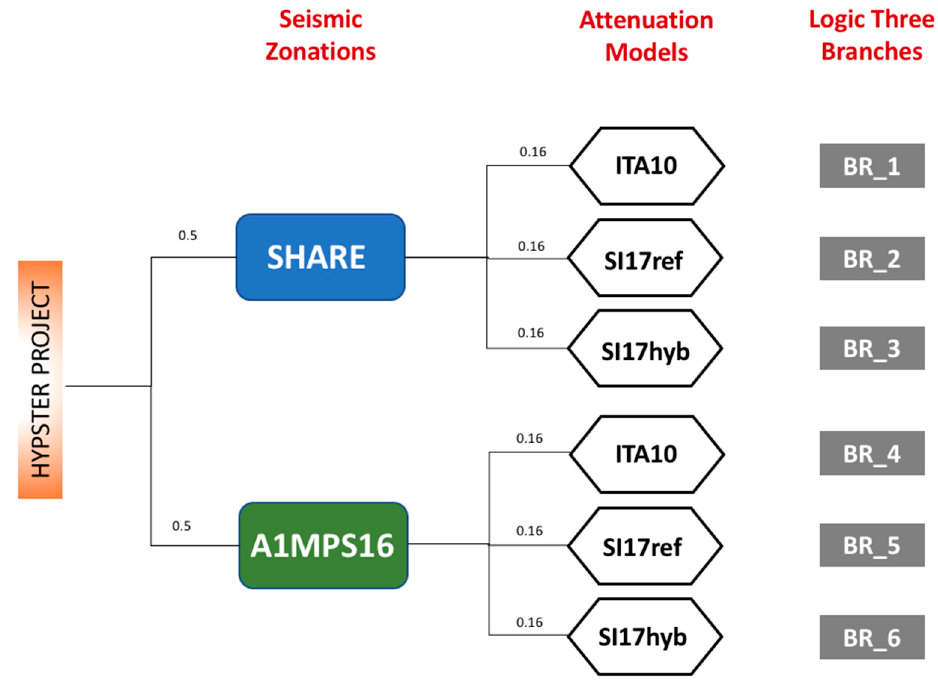
Figure 22. Logic tree used to evaluate the seismic hazard of southern Calabria and Sicily.